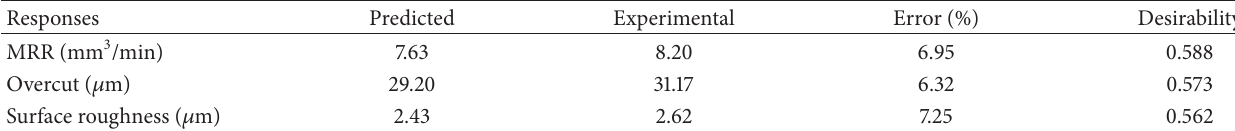
Table 10: Experimental validations of developed models with optimal parameter